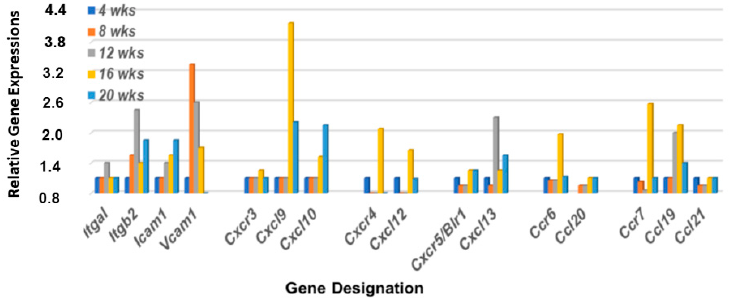
Figure 5. Differential expression profiles for genes encoding integrin, chemokine, and chemokine receptors critical for MZB cell emigration from the MZ regions. Transcriptomic data reveal that genes encoding LFA-1 subunits ( Itga1 and Itg β 2 ), together with Cxcl13 , show a coordinated upregulated expression at 12 wks of age in the lacrimal glands of C57BL/6.NOD- Aec1Aec2 mice. Chemokine receptors Cxcr4 and Ccr7 , together with their ligands Cxcl12 and Ccl19 , show strong upregulations at 16 wks of age, while chemokine receptor Cxcr3 and chemokine ligands Ccl20 and Ccl21 exhibit no upregulated